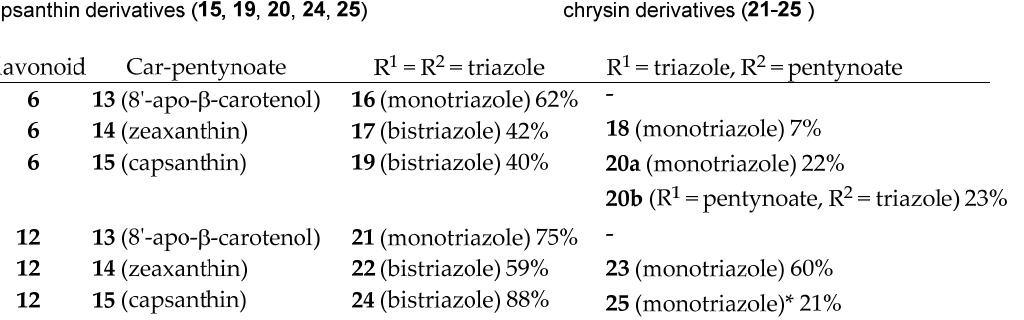
Figure 2. Coupling of 7-azidohexyl ethers of daidzein and chrysin with carotenoid pentynoates by azide-alkyne click-reaction. *In compound 25 , the R 1 and R 2 groups are interchangeable.